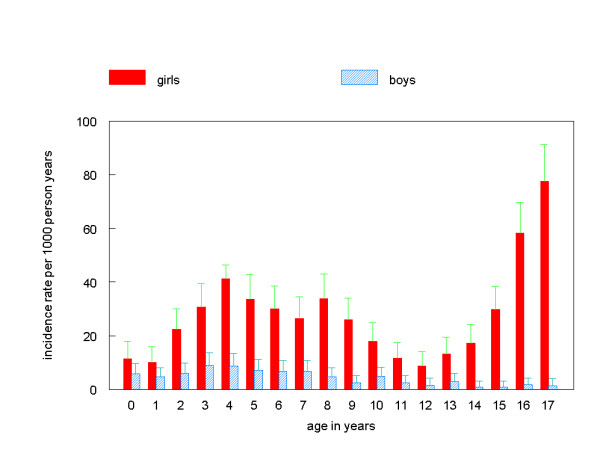
Incidence rates of urinary tract infections by age for boys and girls, 95% error bars.